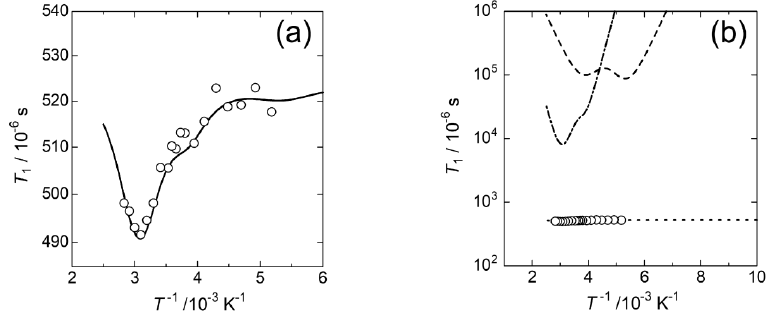
Figure 2. 1 H spin-lattice relaxation time ( T 1 ) for the closed form of ELM-11 as a function of reciprocal temperature: ( a ) expanded and ( b ) overall views. The solid line in ( a ) is the result of fitting to Equation (8). The dotted, dashed, and chain-dotted lines are R 1p , R HH , and R FF , respectively.